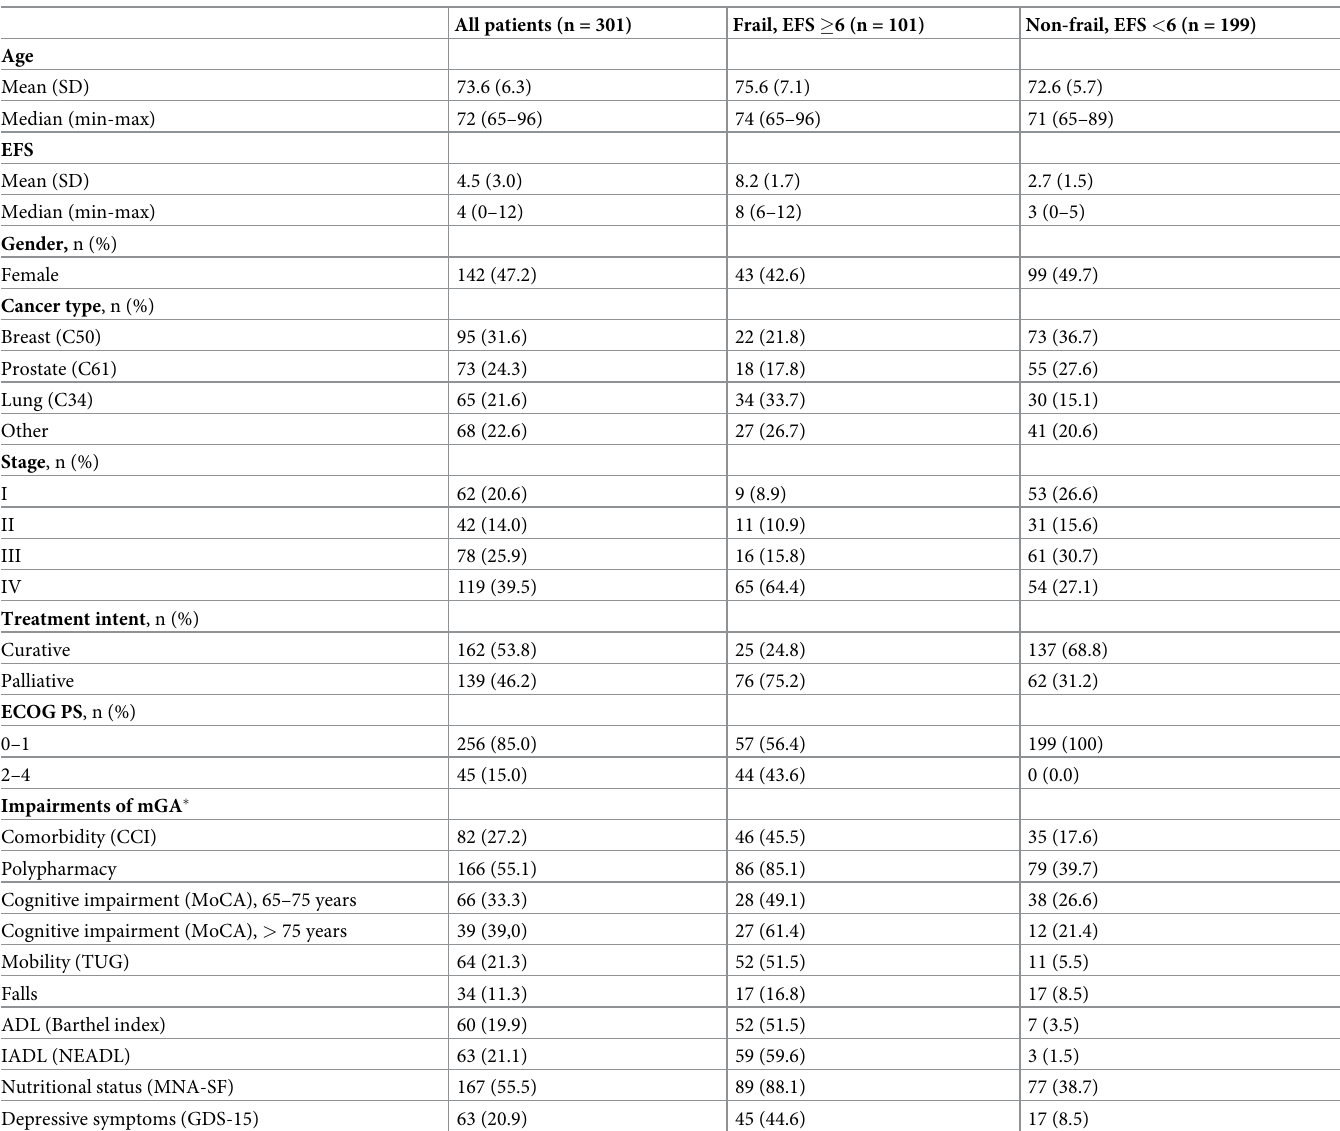
Table 2. Baseline